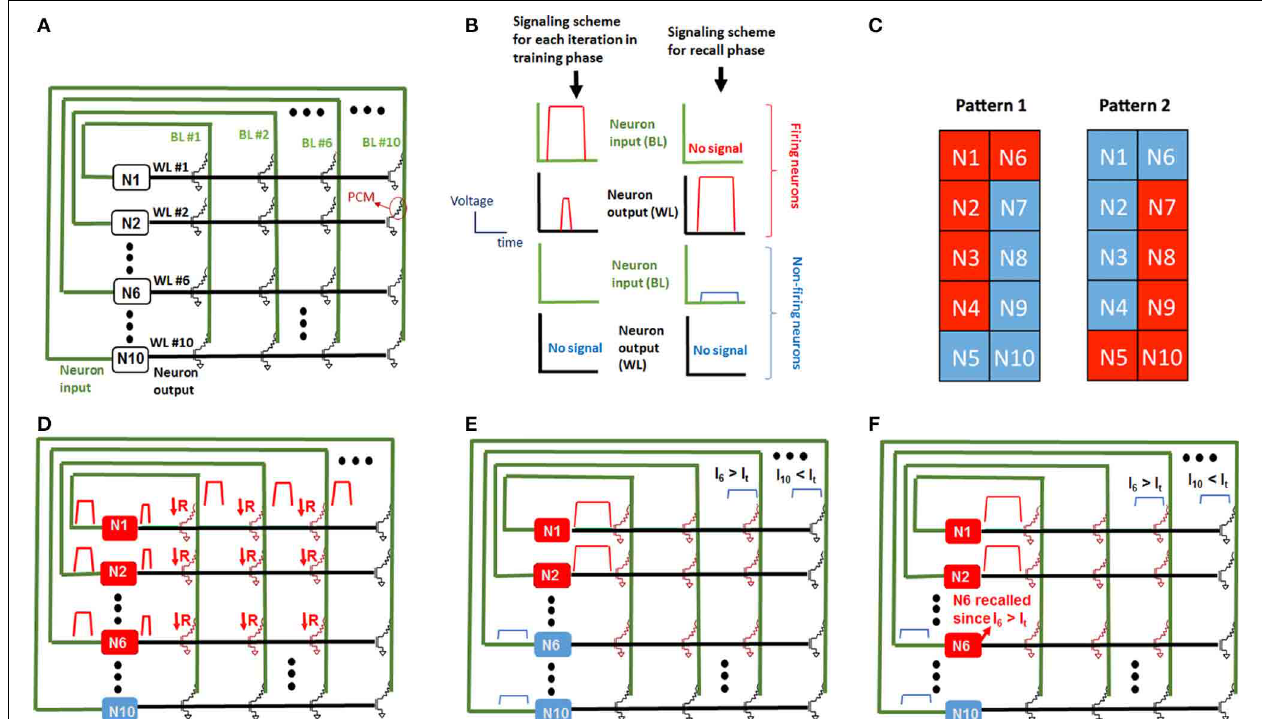
FIGURE 3 | Neural network realized and how it is implemented with the memory array is explained. (A) Shows the recurrently connected Hopfield network implemented in the learning experiment. Pulsing scheme during training as well as recall is shown in (B) . We train the network with two patterns as shown in (C) , where red pixels correspond to ON and blue pixels correspond to OFF. Numbers in pixels correspond to the neuron number associated with that pixel. During update phase shown in (D) , the resistance of synaptic elements connected to non-firing neurons do not change, since no pulse is applied at the WL node of non-firing neurons during update phase. The synaptic connections between firing neurons, however, are